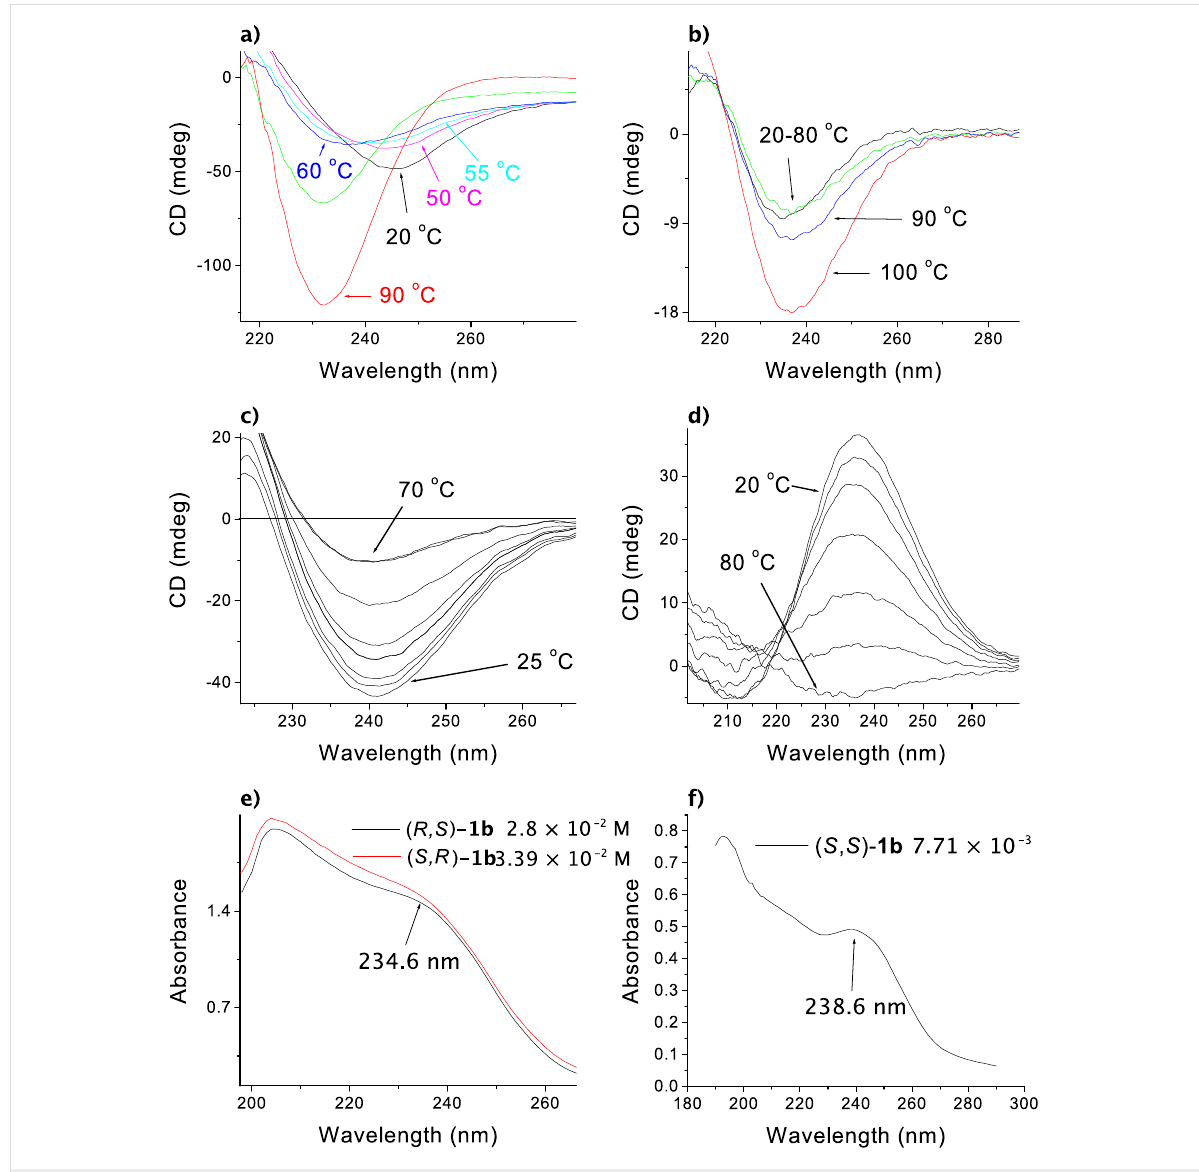
Figure 8: Temperature dependent CD spectra of: a) ( S,R )- 1b decalin gel ( c = 3.4·10 − 2 M); b) ( S,S )- 1b decalin gel ( c =7.6·10 − 3 M); c) 5a ethanol gel ( c =1·10-2 M) and d) ( S,S )-bis(Leu)oxalamide I 1-butanol gel ( c = 2.8·10 − 2 M); e), f) UV spectra of ( S,R )- 1b (red curve), ( R,S )- 1b and ( S,S )- 1b taken in decalin at specified concentrations.